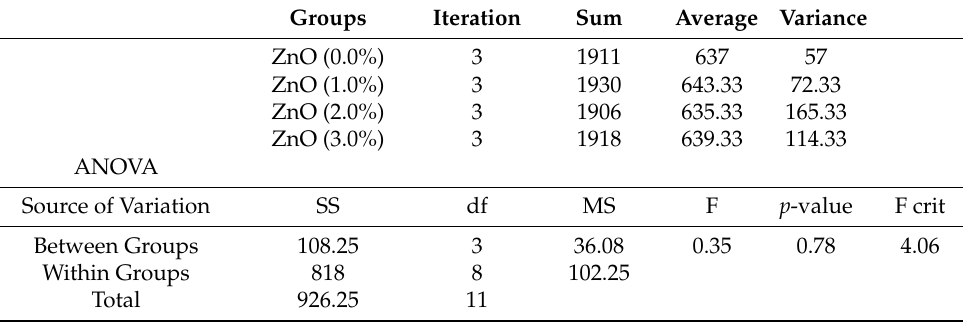
Table 3. Density values of Nano MDF containing UF-ZnO nanofillers.